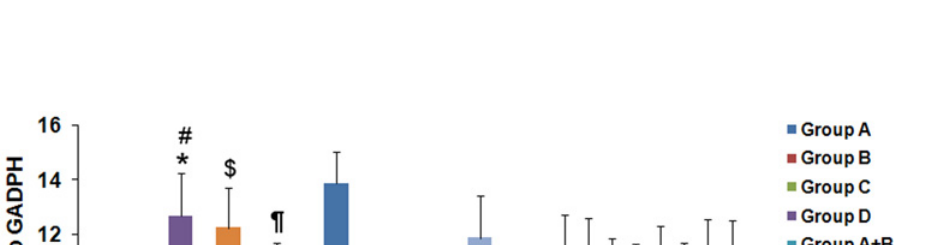
Fig 2. Effect of H . pylori infection and family histories of gastric cancer on protein expression of FHIT, IL-8 and P73 before eradication of H . pylori . Group A: patients with both H . pylori infection and family histories of gastric cancer. Group B: patients with H . pylori infection and without family histories of gastric cancer. Group C: patients without H . pylori infection and with family histories of gastric cancer. Group D: patients without both H . pylori infection and family histories of gastric cancer. Data were expressed as the mean ± standard deviation. Statistical differences were determined by Kruskal-Wallis rank test. Compared with Group A, * P < 0.01; compared with Group B, # P < 0.05; compared with Group A+B, $; compared with Group A+C, ¶ P < 0.05.